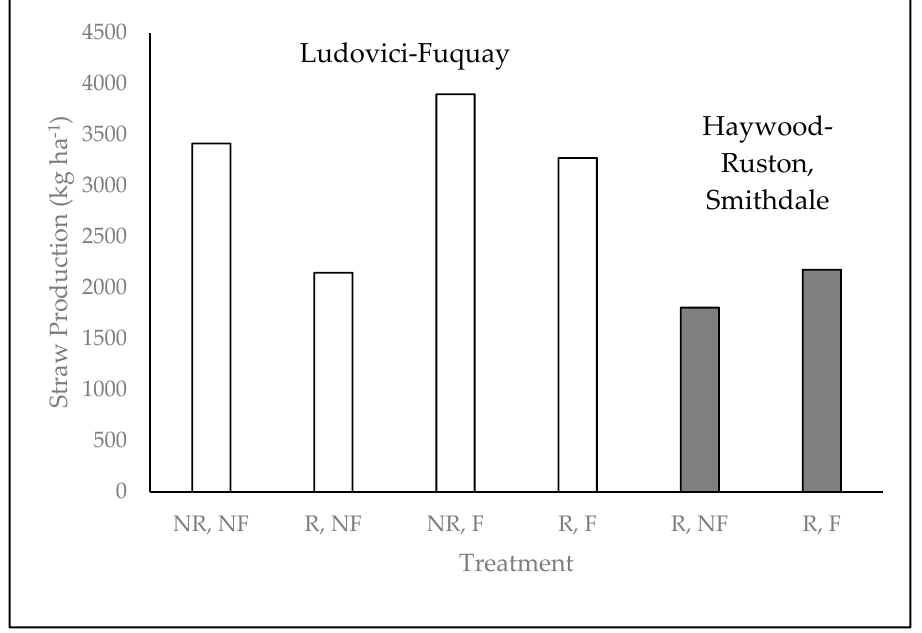
Figure 3. Post-thinning mean annual pine straw production [26] or litterfall over the study period by treatment [27]. Treatments: no rake, no fertilization (NR, NF); rake, no fertilization (R, NF); no rake, fertilization (NR, F); rake, fertilize (R, F) (refer to Tables 3 and 4 for study details, information on fertilizer treatments, and statistical test results). Forests 2020 , 11 , x FOR PEER REVIEW